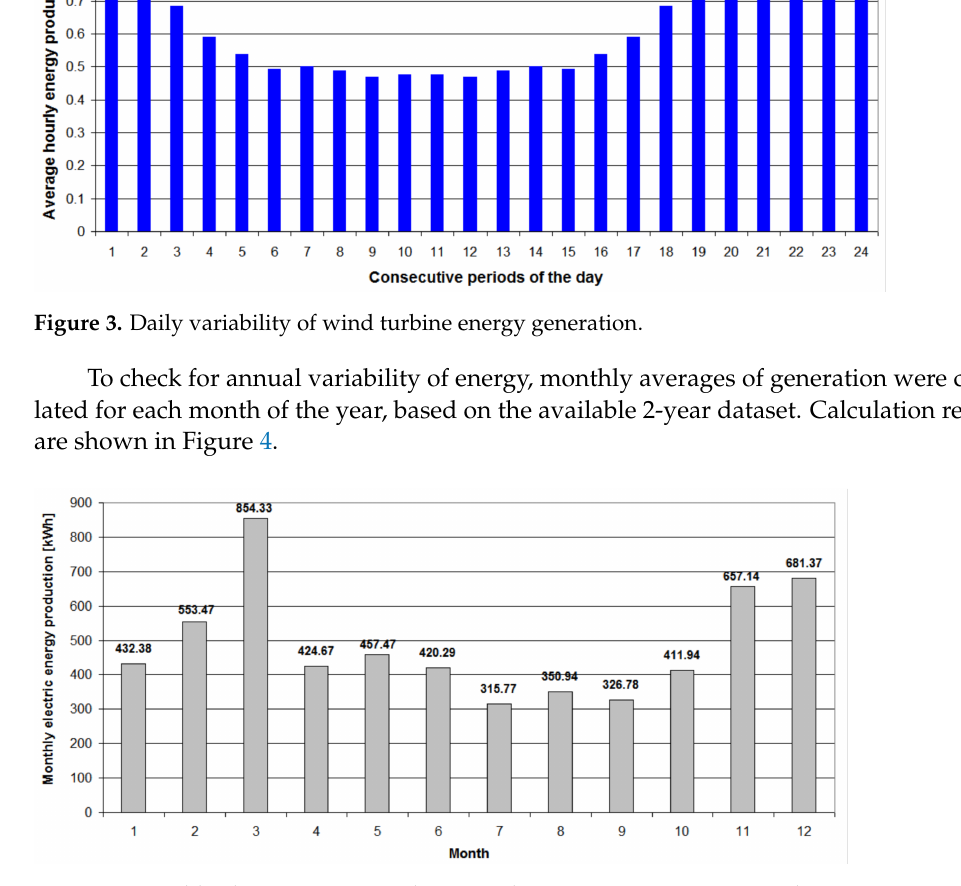
Figure 4. Monthly electric energy production—the mean over a 2-year